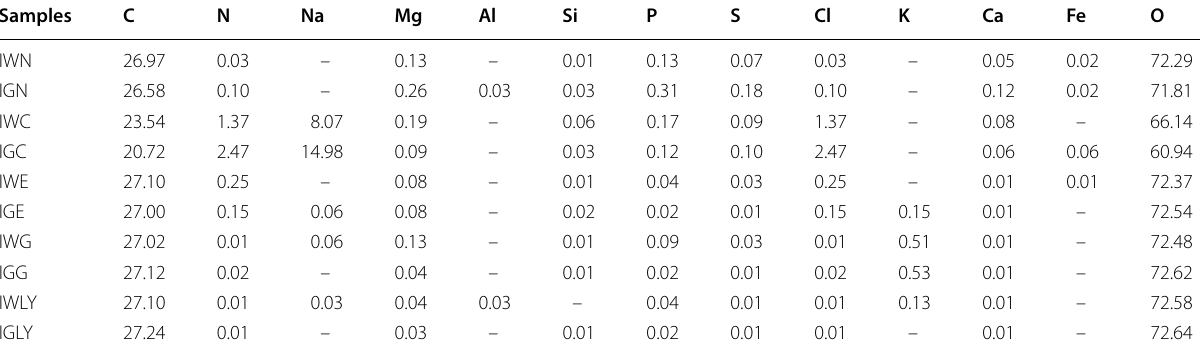
C-content values are slightly higher than the actual values. All samples were coated with a thin layer of carbon prior to microscopy